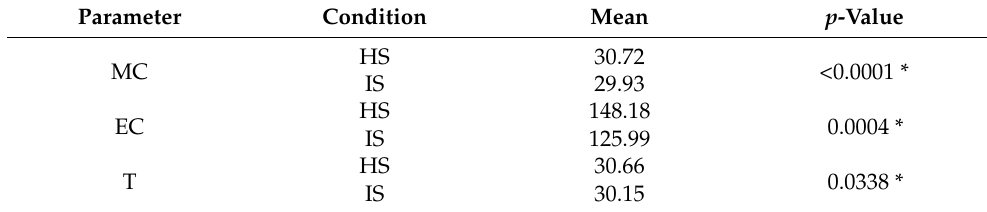
Table 2. Mean and p -value of weekly